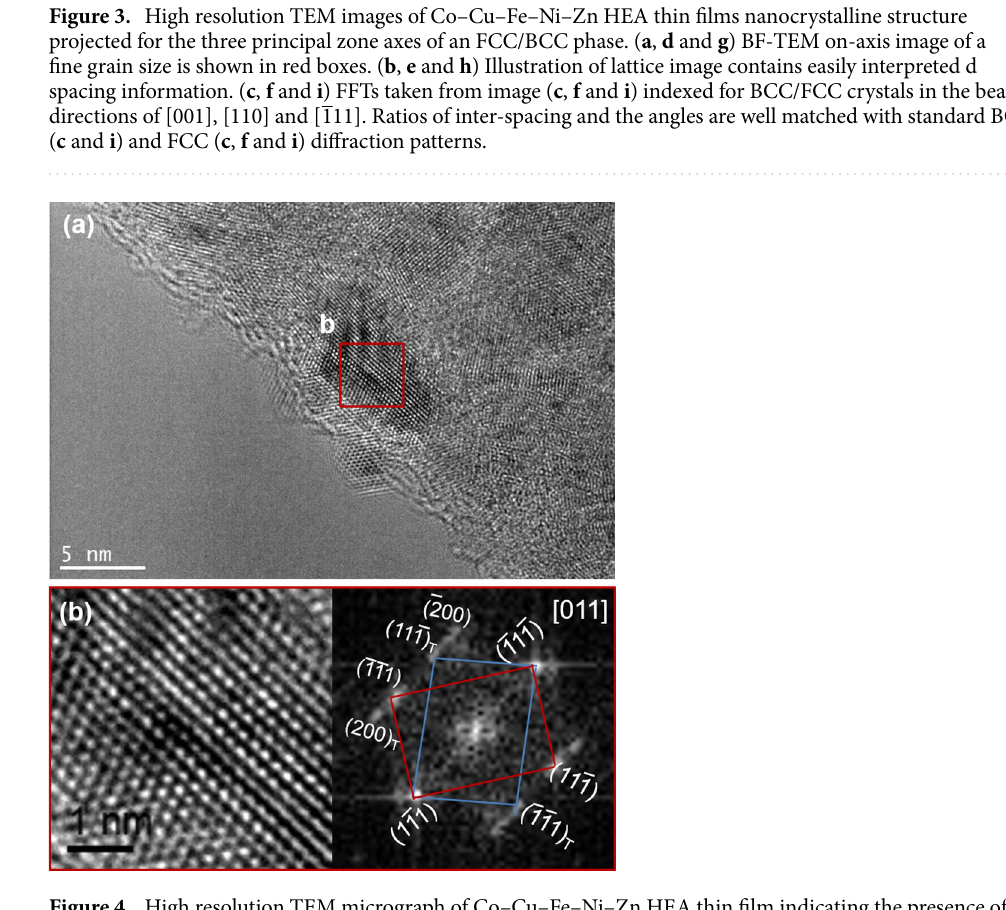
Figure 4. High resolution TEM micrograph of Co–Cu–Fe–Ni–Zn HEA thin film indicating the presence of